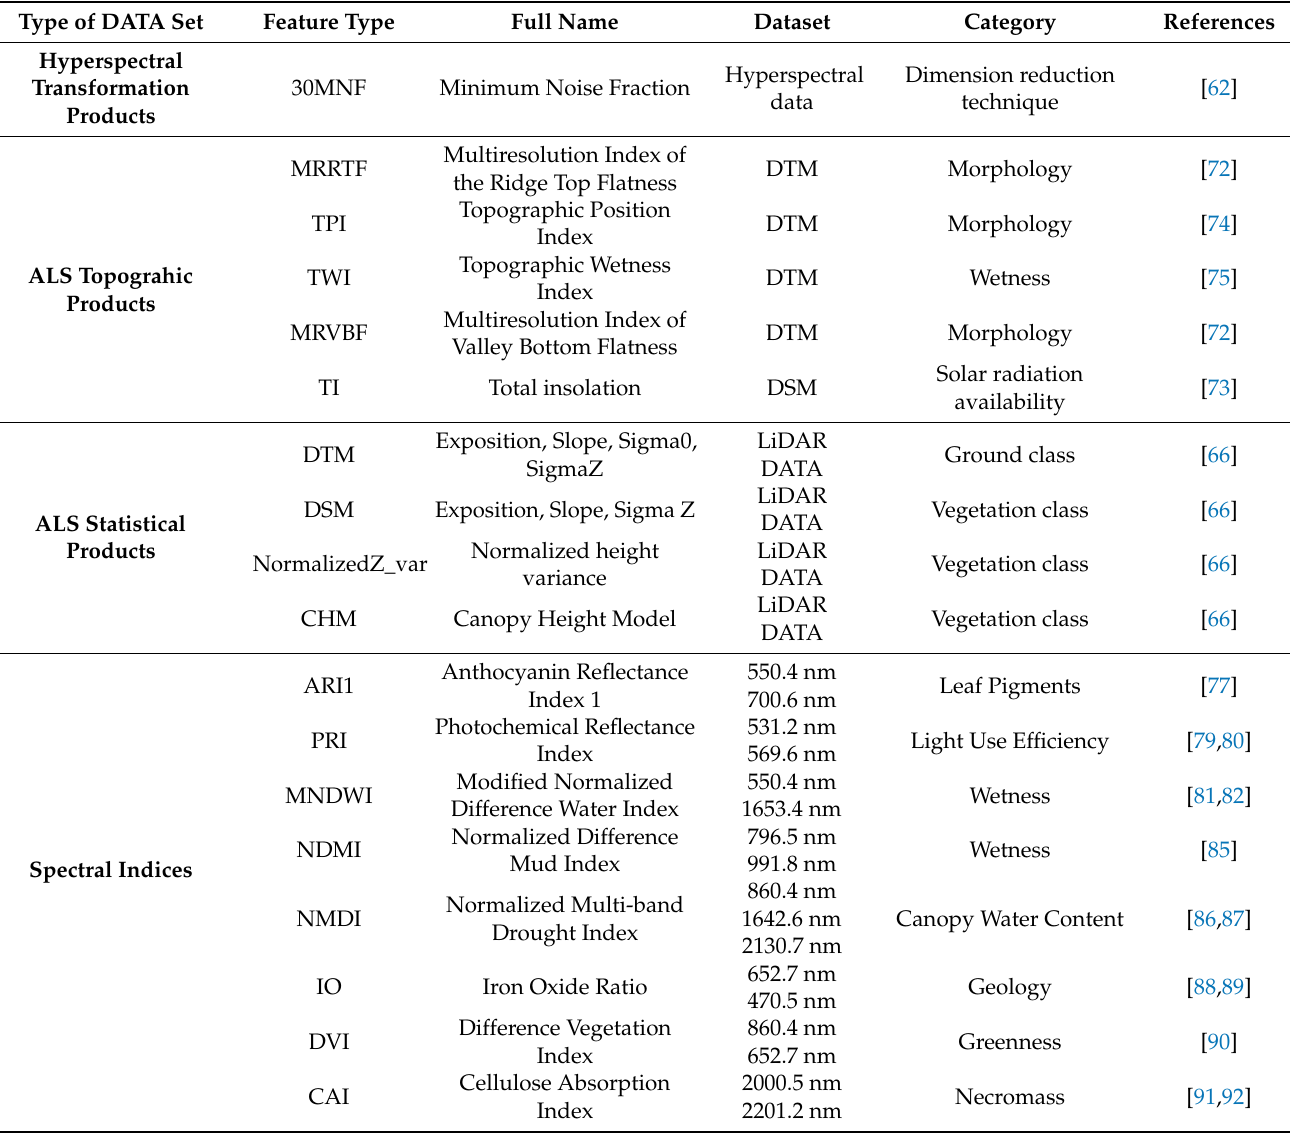
Table 7. Recommended RS sub-products in the identification of transition mires and quaking bogs in the Biebrza river valley (UB